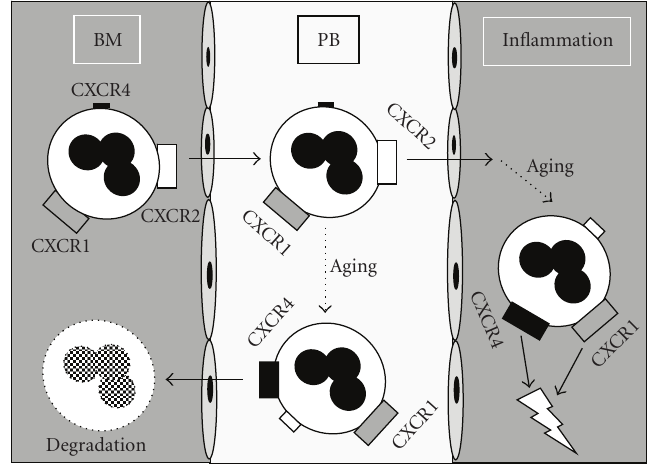
Figure 3: Potential function of CXC chemokine receptors in human neutrophils during aging in vivo. In this model of the putative function of CXC chemokine receptors in aging human neutrophils, the increased expression of CXCR4 in senescent cells circulating in the peripheral blood (PB) is paralleled by loss of CXCR2, resulting in migration to sites with a high SDF-1 concentration such as the bone marrow (BM) or alternatively to other sites of neutrophil sequestration, where they undergo degradation. Similar to in vivo observations in the mouse, CXCR2 might also contribute the release of human neutrophils from the bone marrow. Both IL-8 receptors, CXCR1 and particularly CXCR2, may contribute to extravasation of PMN. In the tissue, further migration toward areas of inflammation (inflamm.) is still mediated by CXCR1 together with CXCR4, even when the process of aging has already